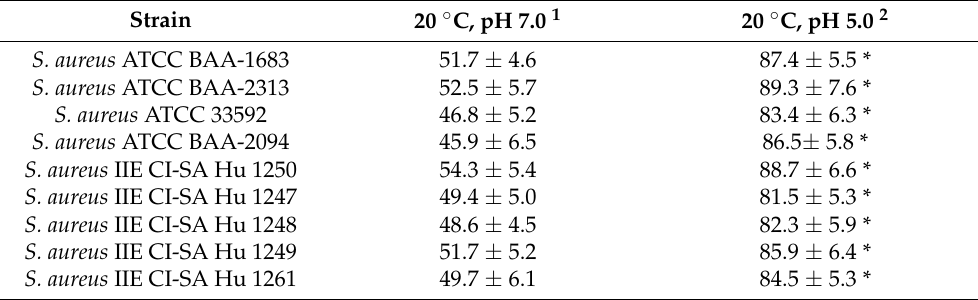
Table 6. Co-aggregative abilities of LF3872 with antibiotic-resistant S. aureus strains isolated from humans and